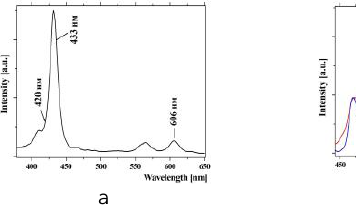
a b c Fig.2. Fluorescence excitation at  rec. =680 nm (a), fluorescence: at  exc. = 420 nm – 1; at  exc. = 433 nm – 2 (b) and phosphorescence: at  exc. = 420 nm – 1; at  exc. = 433 nm – 2 (c) spectra of Zn-TAPP– (Сurc) 4 in ethanol at 77